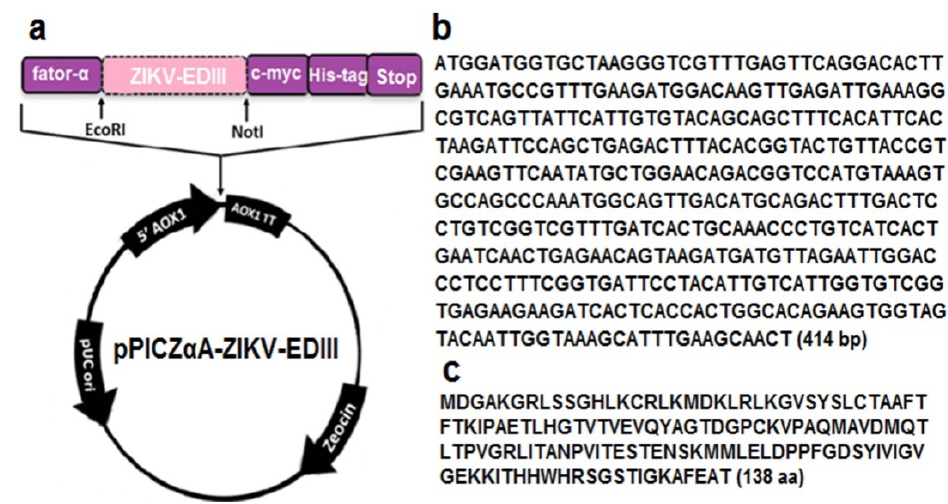
Figure 1. The pPICZ α A-ZIKV-EDIII vector. ( a ) Schematic view of the expression cassette and the recombinant plasmid. ( b ) Genic sequence of ZIKV-EDIII optimized for expression in yeast. ( c ) Amino acid sequence of ZIKV-EDIII.